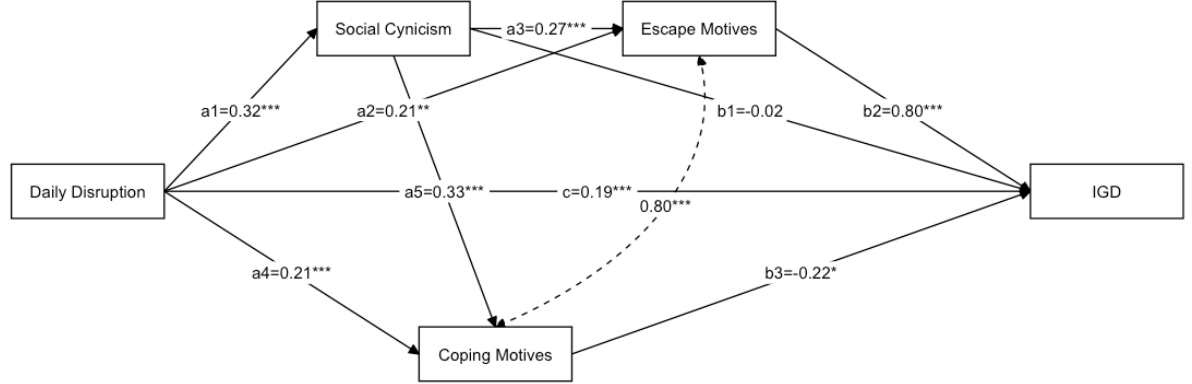
Figure 1. Results of the Serial Mediation Model. Note : Path coefficients are from the standardized regression ( β ). N = 203; * p < 0.05, ** p < 0.01, *** p <